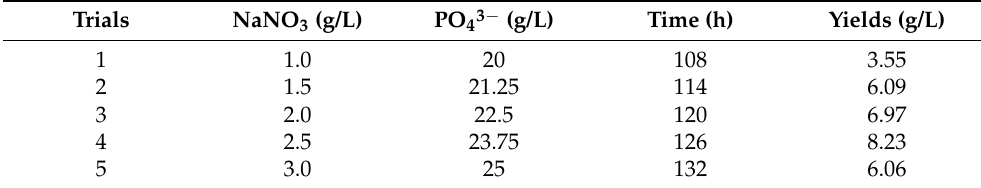
Table 2. Steepest ascent experiment design and response